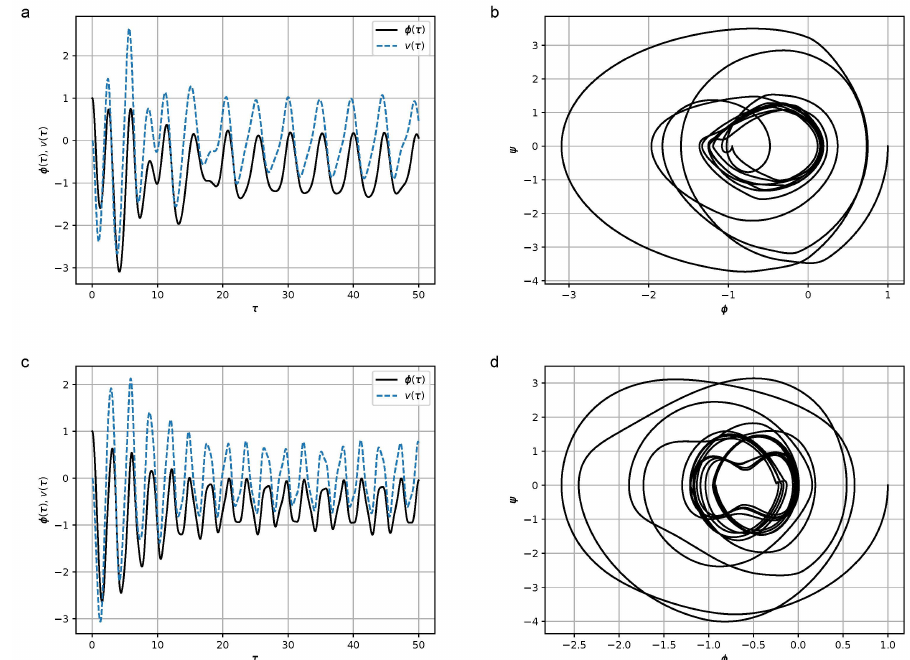
Figure 11. ( a ) Dependence of the declination angle of the pendulum, ϕ ( τ ) , and the stress, v ( τ ) , from the dimensionless time at Ω = 1.3 and H = 8.0; ( b ) Phase portrait of the oscillations of the pendulum ψ ( ϕ ) at Ω = 1.3 and H = 8.0; ( c ) Dependence of the declination angle of the pendulum, ϕ ( τ ) , and the stress, v ( τ ) , from the dimensionless time at Ω = 5.0 and H = 8.0; ( d ) Phase portrait of the oscillations of the pendulum ψ ( ϕ ) at Ω = 5.0 and H = 8.0. Parameter values were σ = 1.5, ω = 1.2, and K = 2.0. Initial conditions were ϕ ( 0 ) = 1, ψ ( 0 ) = 0, and σ ( 0 ) = 0.